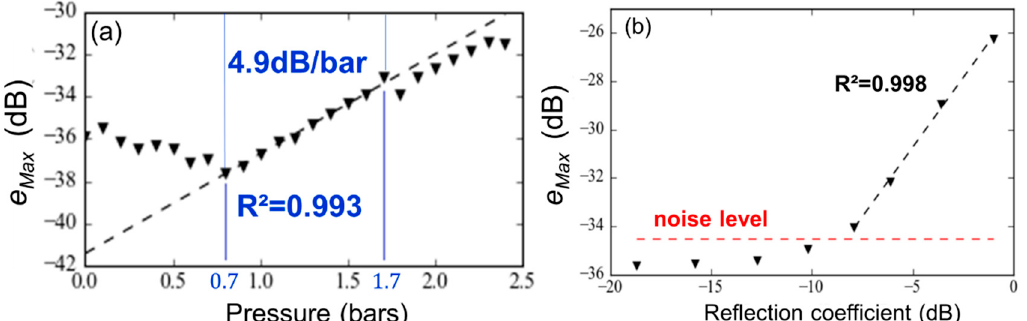
Figure 8. ( a ) Variation of the statistical estimator e Max with respect to the applied pressure (the sensing mode was located 7.5 m from the radar). A linear variation was obtained from 0.7 and 1.7 bars with the coefficient of determination R 2 of 0.993 and slope (or measurement sensitivity) of 4.9 dB/bar; ( b ) Variation of the statistical estimator e Max as a function of the input reflection coefficient of the variable resistor (the sensing mode was located 6.0 m from the radar). The noise level at this position is around − 34.5 dB.